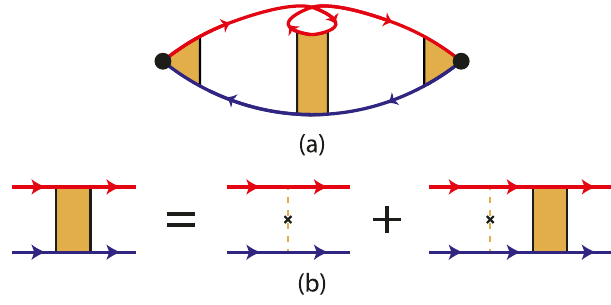
Fig. 2 Feynmann diagrams describing quantum corrections. a Diagrammatic representation of the quantum correction ’ s linear response function, including vertex corrections. The red/blue lines denote retarded/ advanced disorder-averaged Green ’ s functions, the black circles represent the current vertices, and the central orange shaded region represents the Cooperon. b Diagrammatic series for the Cooperon. The orange dashed lines represent scattering from the impurity located at the